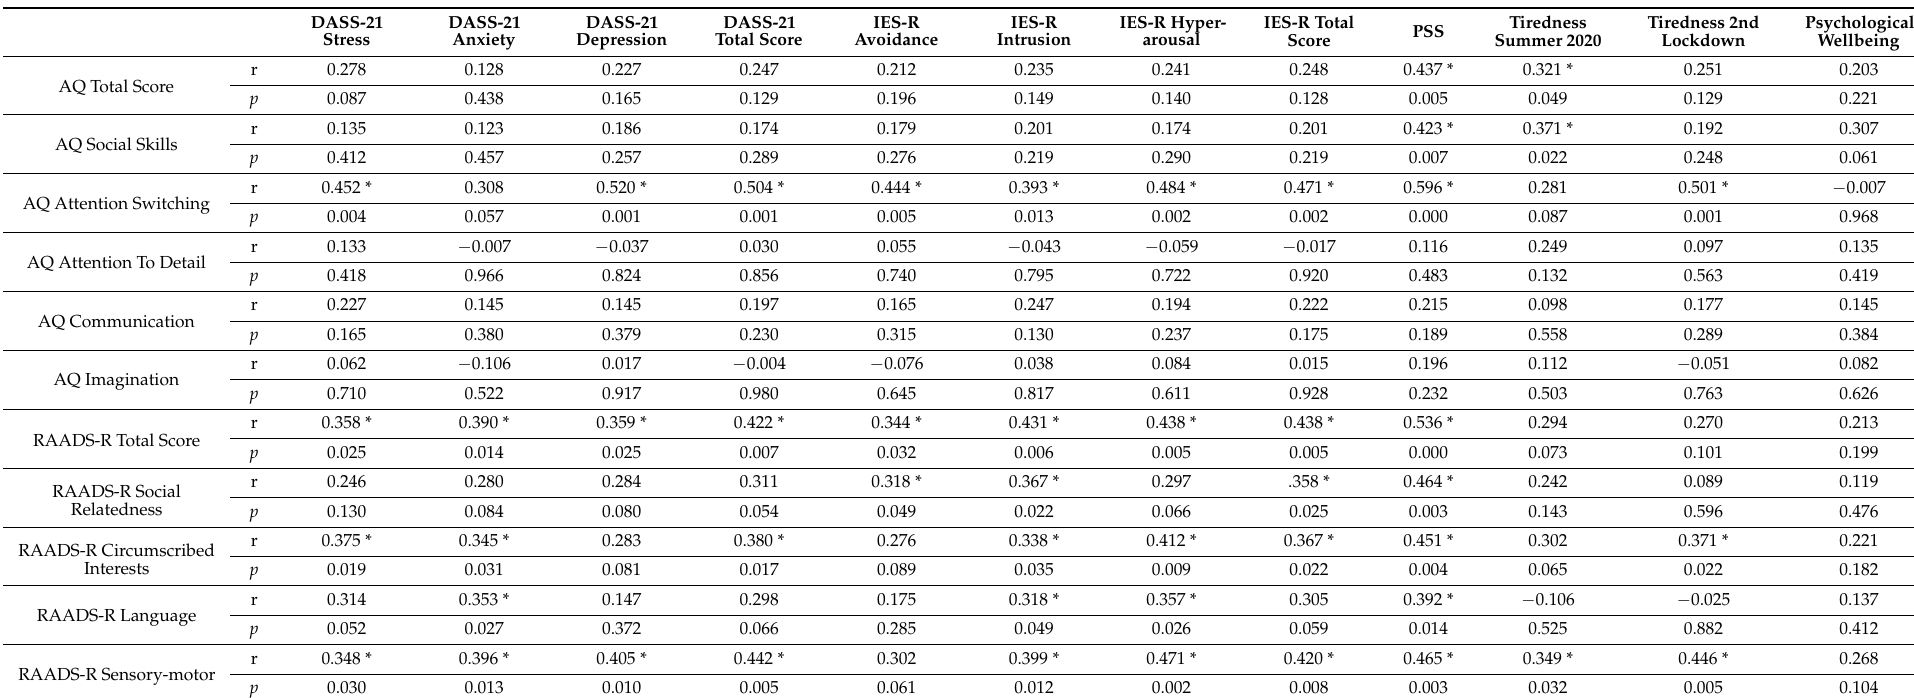
Table 4. Correlational